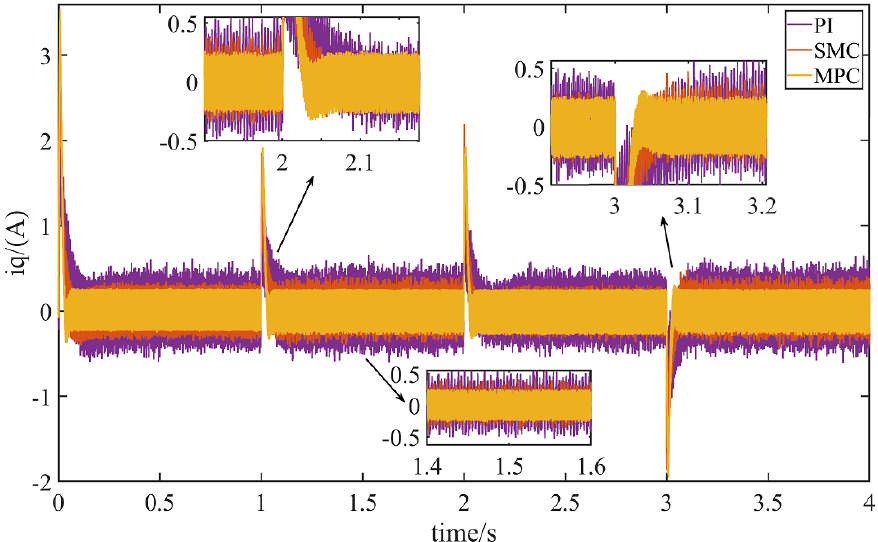
Figure 7. Comparison of the q-axis current waveforms of the three systems.